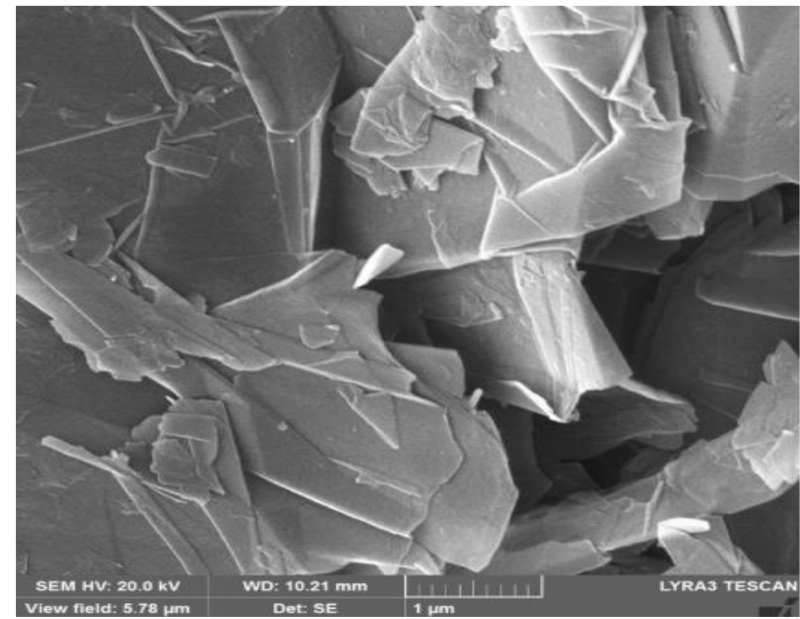
Figure 1. SEM images of supplied